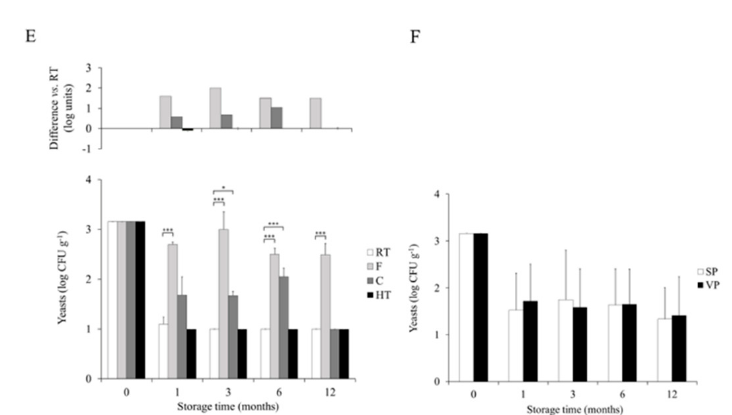
Figure 1. E ff ect of storage temperature and packaging mode on the counts of total bacteria (log colony forming units (CFU) g − 1 ) ( A , B ), lactic acid bacteria (LAB) (log CFU g − 1 ) ( C , D ), and yeasts (log CFU g − 1 ) ( E , F ) in fermented food product (FFP) samples. RT: room temperature; F: freezing; C: cooling; HT: high temperature; SP: standard packaging; VP: vacuum packaging. * p < 0.05, ** p < 0.01, *** p <